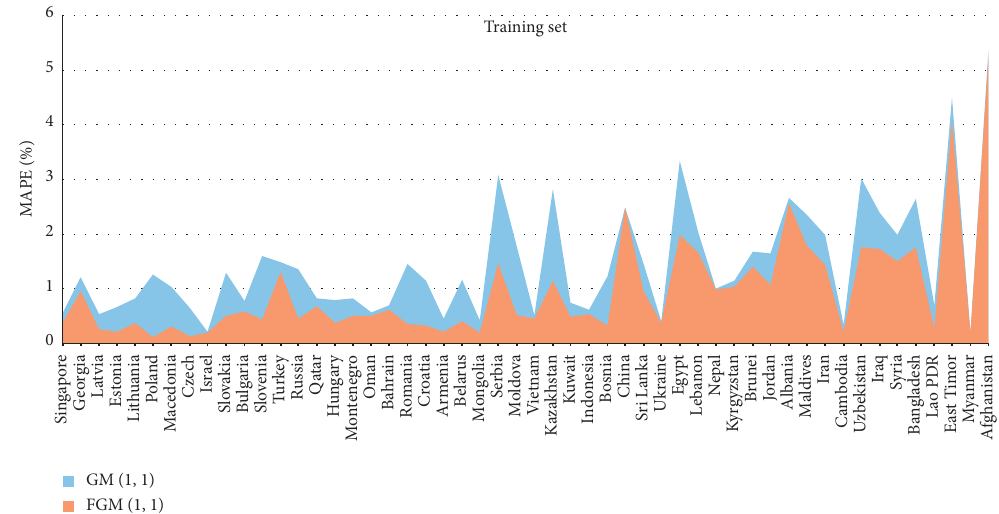
Figure 3: MAPE comparison between GM (1, 1) and FGM (1, 1) in the training set.